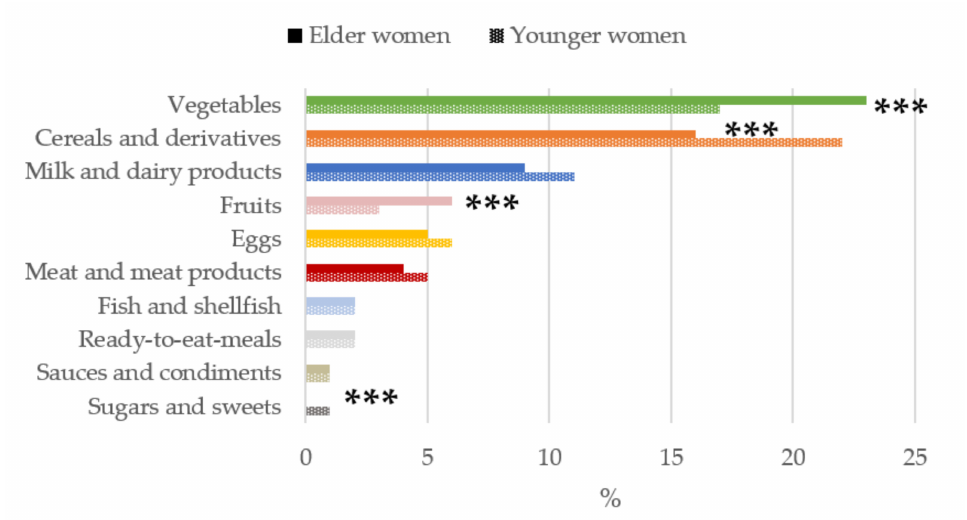
Figure 4. Contribution of main sources (food and beverages) to folates intake by age-group in women of childbearing age from the ANIBES study. *** p < 0.001 difference vs. younger women (Mann–Whitney’s U test).